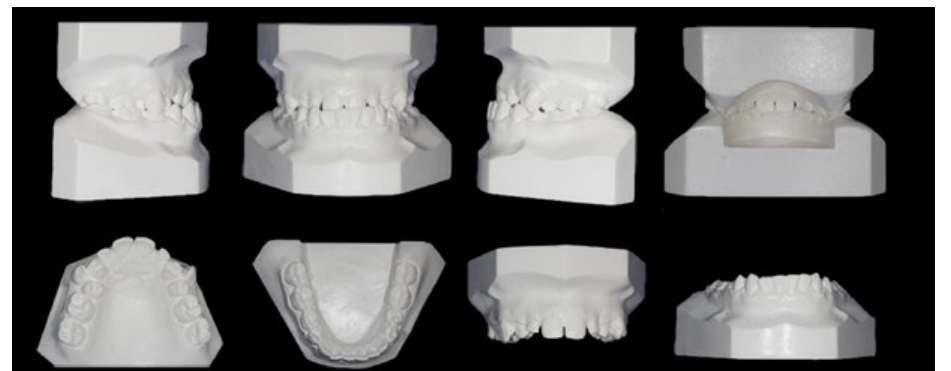
Figure 2. Pretreatment dental casts.